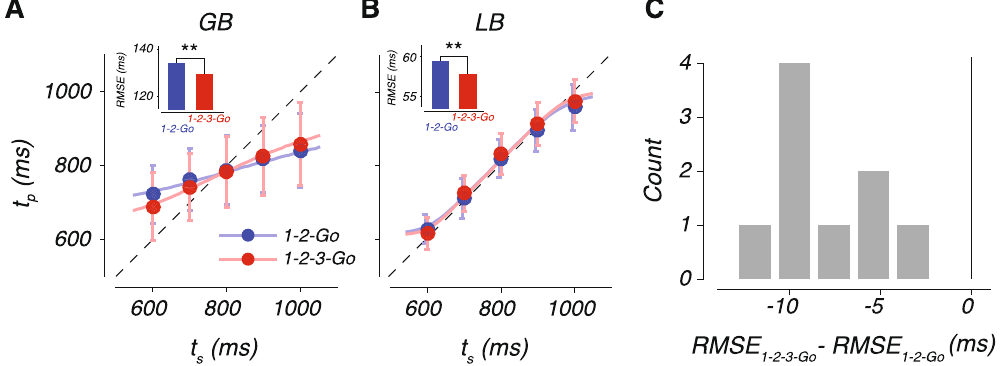
Figure 2. Performance in the interval reproduction task. ( A ) Production interval ( t p ) as a function of sample interval ( t s ) for a low sensitivity subject (GB). Filled circles and error bars show the mean and standard deviation of t p for each t s in the 1-2-Go (blue) and 1-2-3-Go (red) conditions. The dotted unity line represents perfect performance and the colored lines show the expected t p from a Bayes Least-Squares (BLS) model fit to the data. Inset: root-mean-square error (RMSE) in the 1-2-Go (blue) and 1-2-3-Go (red) conditions differed significantly (asterisk, p-value < 0.01; permutation test). ( B ) Same as (A) for a high sensitivity subject (LB). ( C ) The histogram of changes in RMSE across conditions for all subjects. See also Supplementary Table